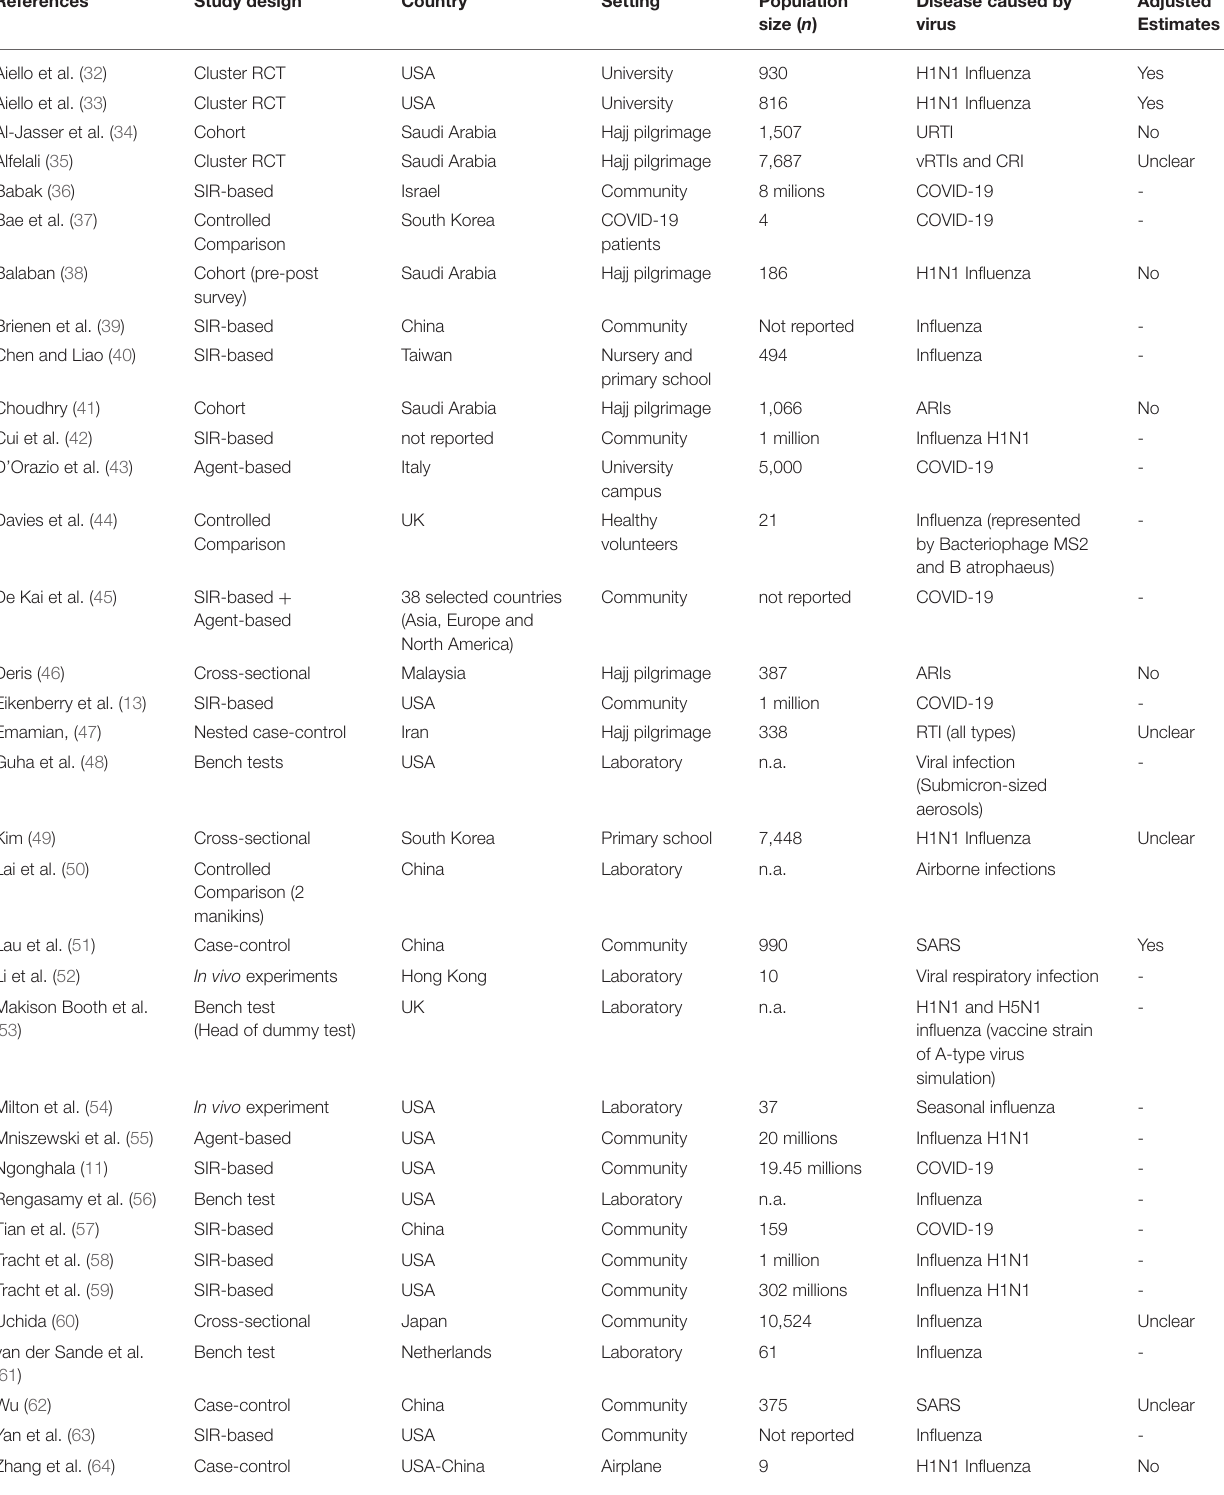
TABLE 1 | General characteristics of the included